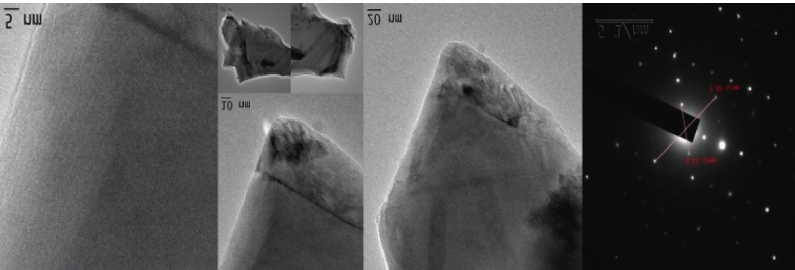
Figure 2: TEM images of the eutectic Al-Si alloy and nano-Al